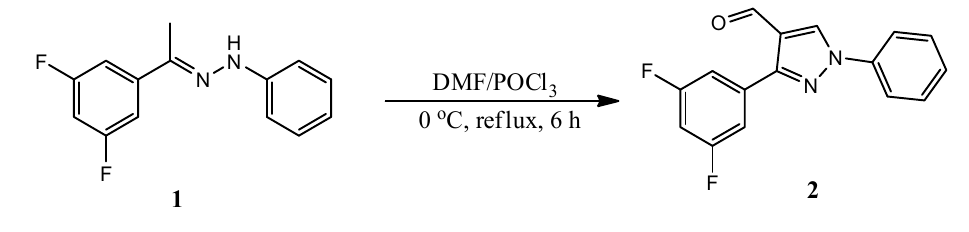
Scheme 1. Scheme for synthesis of compound 2 .